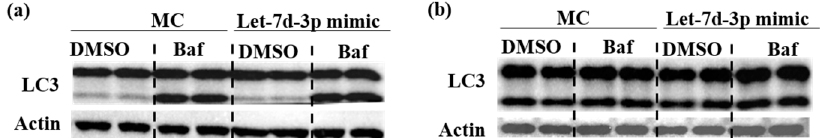
Figure 3. The protective effect of Let-7d-3p is not via the regulation of autophagy. Autophagy flux was accessed by the ratio of LC3 II/I with Bafilomycin A1 (Baf) treatment or Dimethyl sulfoxide (DMSO) for 2 hours. Let-7d-3p did not induce any changes of LC3 II/I with or without Baf in ( a ) H9c2 and ( b ) NRVM.